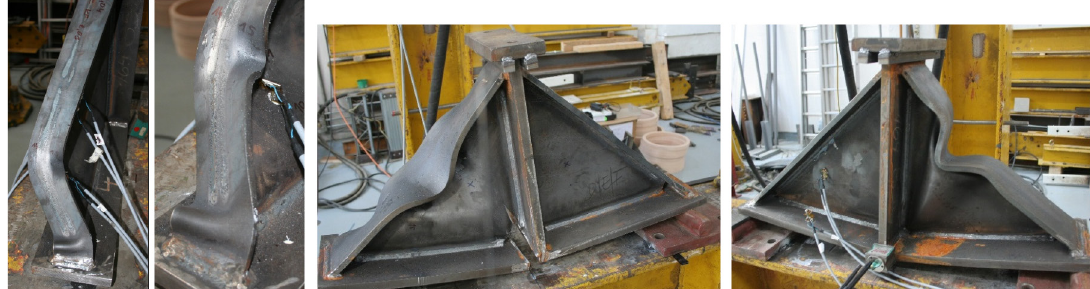
Fig. 4. Specimen D after testing Fig. 5. Specimen E after testing Fig. 6. Specimen F after testing